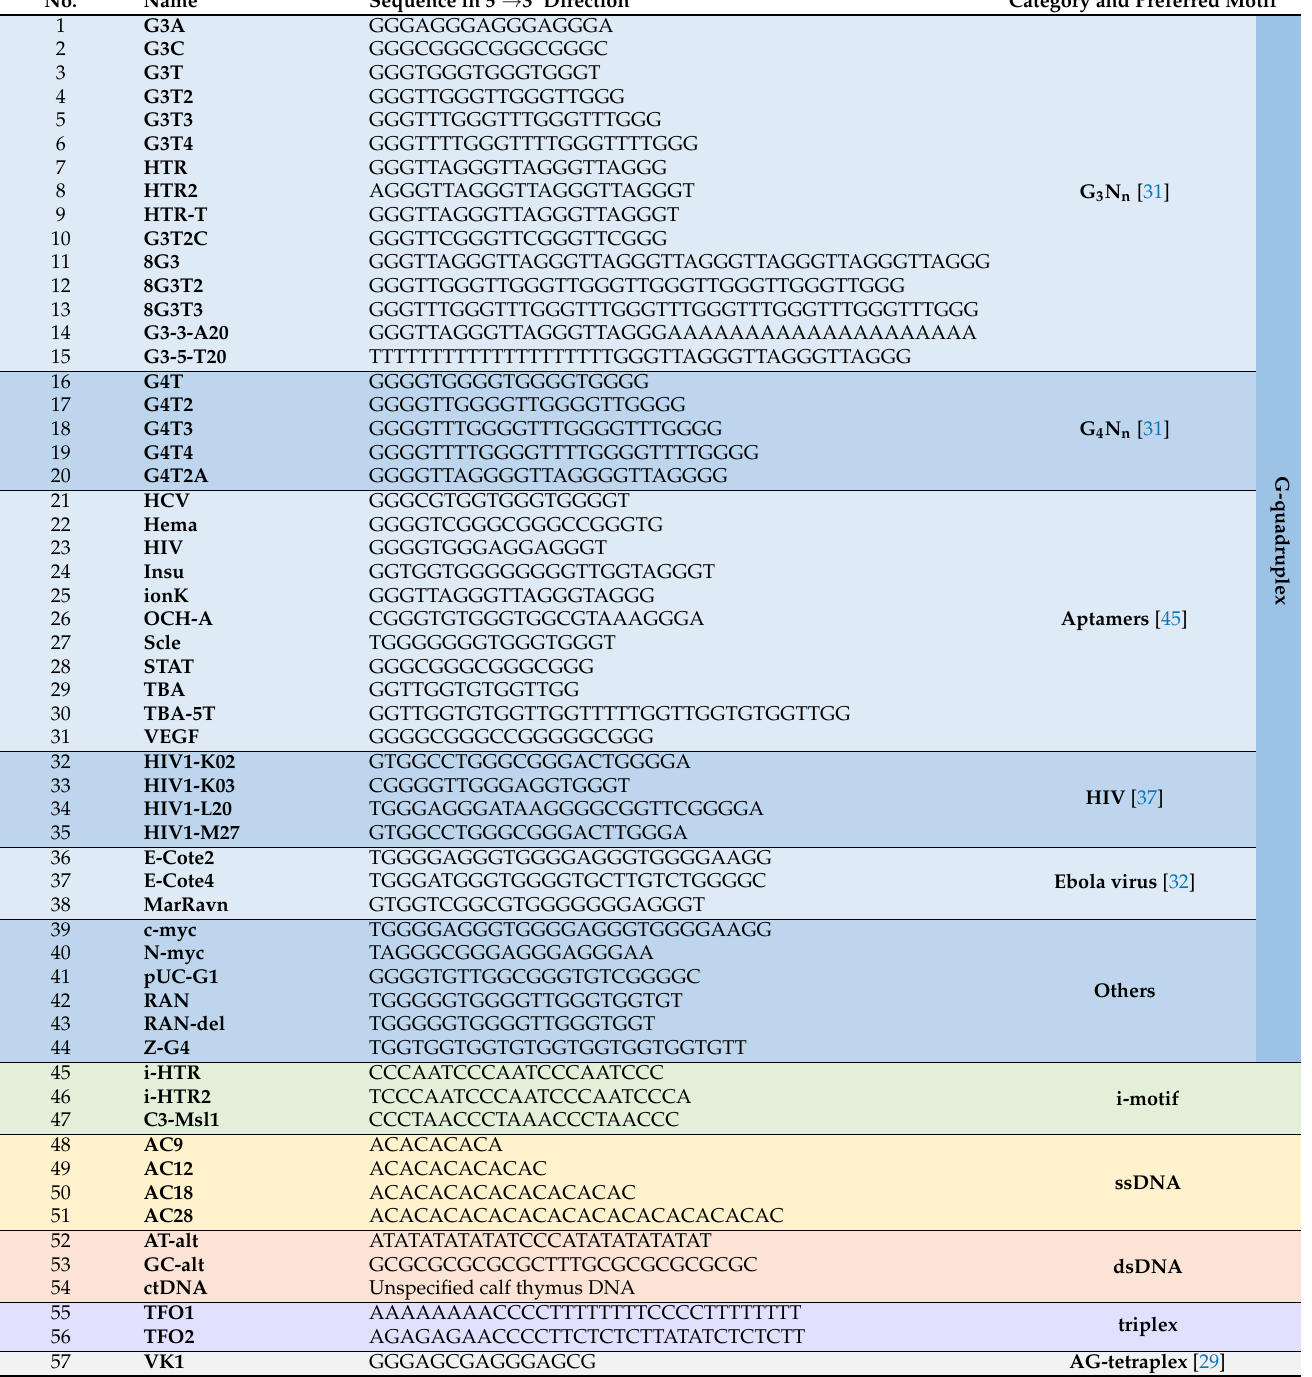
Table 2. Sequences of oligonucleotides used in the present